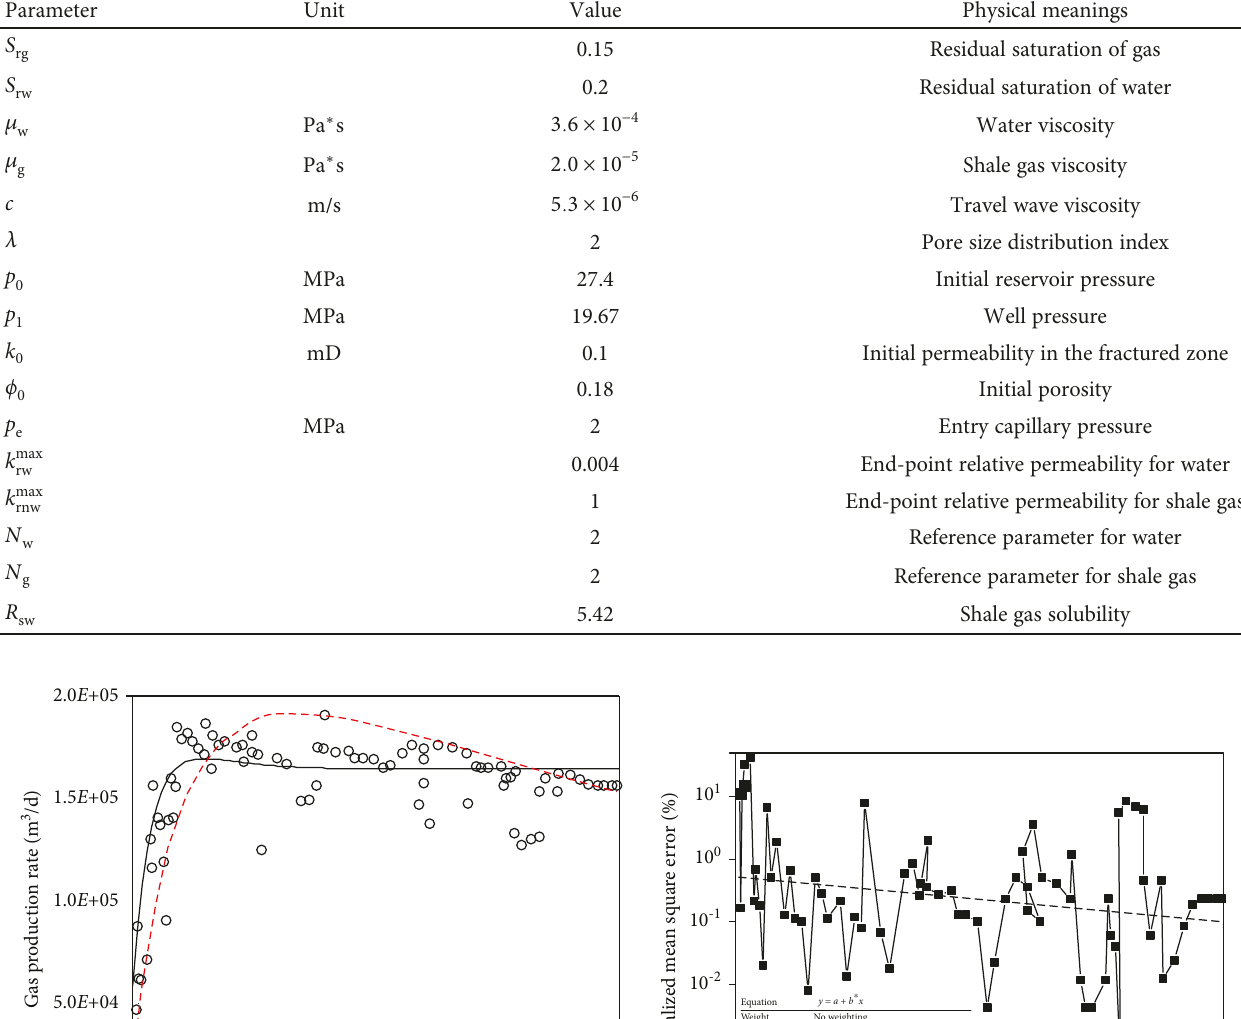
Table 1: Model parameters in the computation for the China shale gas reservoir.